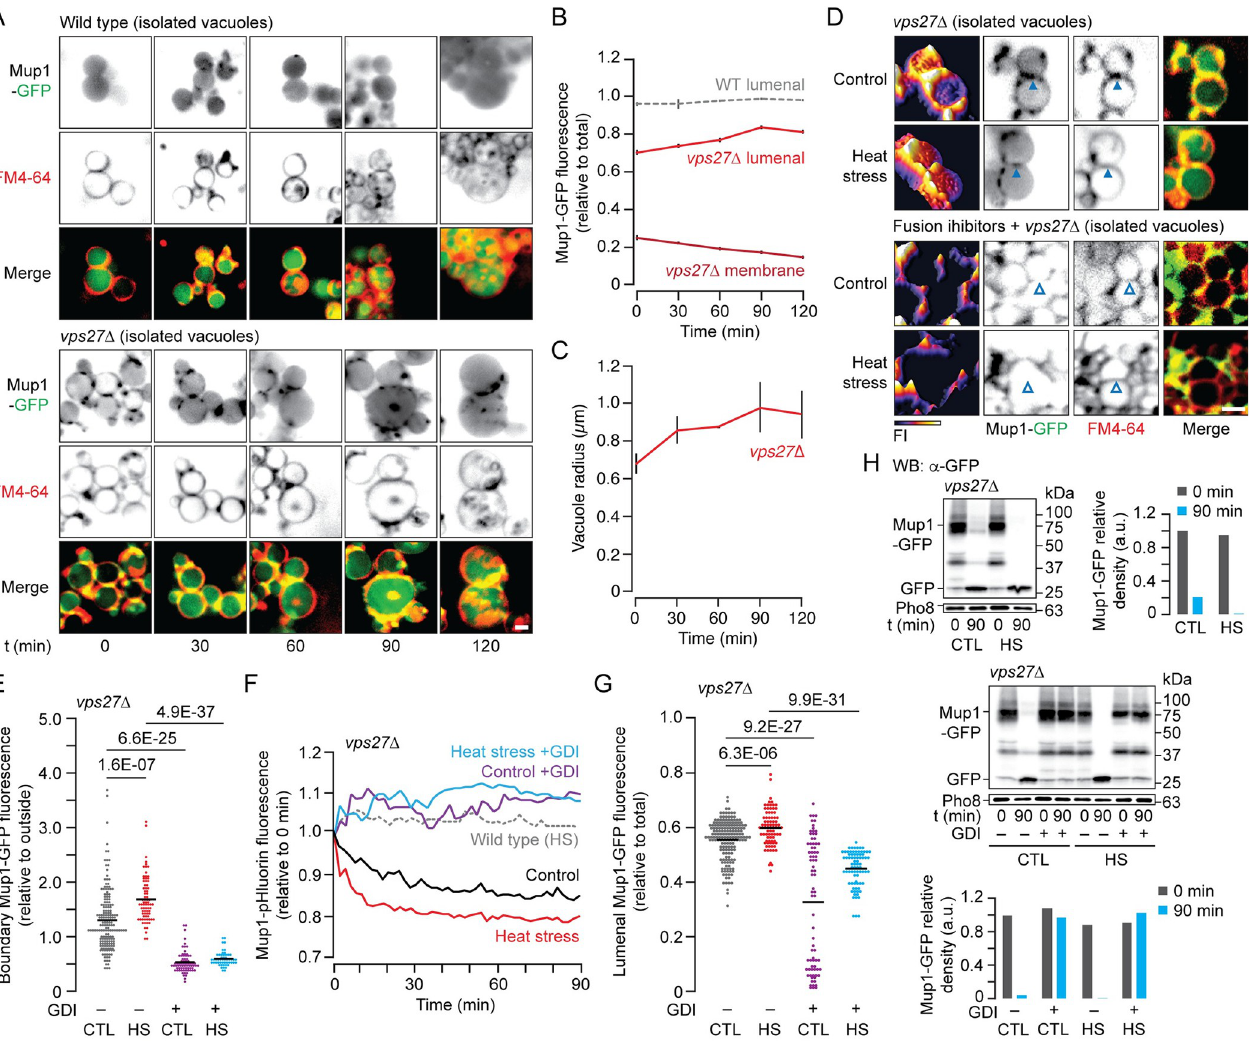
Fig 5. Molecular machinery for Mup1 degradation by the ILF pathway co-purifies with vacuoles. (A) Fluorescence micrographs of vacuoles isolated from wild type or vps27 Δ cells expressing Mup1-GFP before (0 minutes) or after up to 120 minutes of fusion. Vacuole membranes were stained with FM4-64. (B,C) Vacuole radius (C) or Mup1-GFP fluorescence measured within the lumen or on outside membranes (B) of vacuoles isolated from wild type (WT) or vps27 Δ cells before (0) or after fusion (up to 120 minutes). n values for 0, 30, 60, 90,120 minutes are 63, 52, 83, 115, 114 (WT); 93, 177, 128, 126, 104 ( vps27 Δ ) vacuoles analyzed. (D) Fluorescence micrographs of vacuoles isolated from vps27 Δ cells expressing Mup1-GFP after 30 minutes of fusion in the absence (control) or presence of heat stress (HS), and with or without fusion inhibitors (4 μ M rGdi1 and 3.2 μ M rGyp1-46). Vacuole membranes were stained with FM4-64 and 3-dimensional fluorescence intensity (FI) plots of Mup1-GFP are shown. Arrowheads indicate boundary membranes either enriched with (closed) or depleted of (open) Mup1-GFP. (E, G) Mup1-GFP fluorescence measured within boundary membranes (E) or the lumen (G) of vacuoles isolated from vps27 Δ cells in the absence (control; CTL) or presence of heat stress (HS), and with or without fusion inhibitors (GDI) after 30 minutes of fusion. n values for CTL, HS are 176, 76 vacuoles analyzed without GDI; 73, 52 with GDI. (F) Relative fluorescence of vacuoles isolated from WT or vps27 Δ cells expressing Mup1-pHluorin recorded over time during homotypic vacuole fusion in vitro in the absence (control; CTL) or presence of heat stress (HS) and with or without fusion inhibitors (GDI). n = 3 for each condition, representative traces shown. (H) Western blot analysis of Mup1-GFP degradation before (0) or after (90 minutes) fusion of vacuoles isolated from vps27 Δ cells in the absence or presence of heat stress (HS) pretreated without (top) or with (bottom) fusion inhibitors (GDI). Blots were stained with antibodies to GFP or Pho8 (load control). Estimated molecular weights indicated. Intact Mup1-GFP band densities relative to control (0 min) normalized to load controls were calculated for each condition shown. n = 3 for each condition tested. Means (bars) ± S.E.M. and results of Student t-tests are shown. Scale bars, 1 μ m.